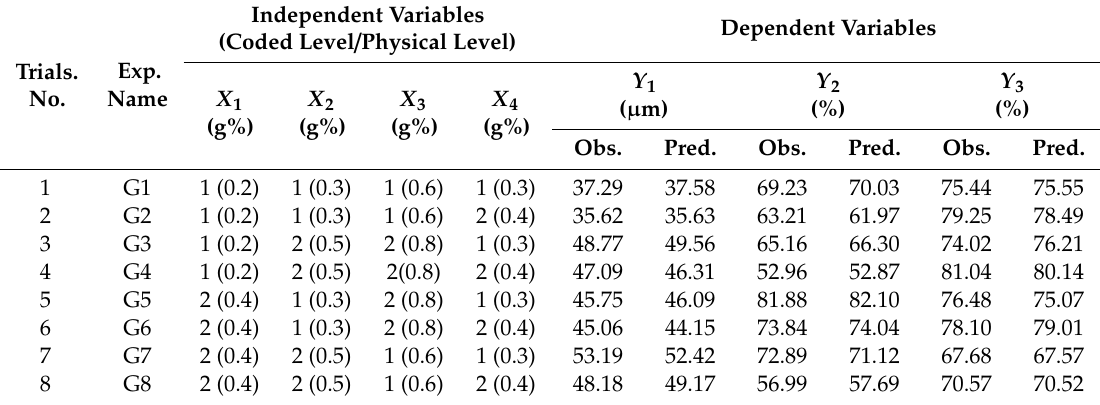
Table 4. 2 4 Taguchi design: physical values for the independent variables; the observed and predictive values for di ff erent